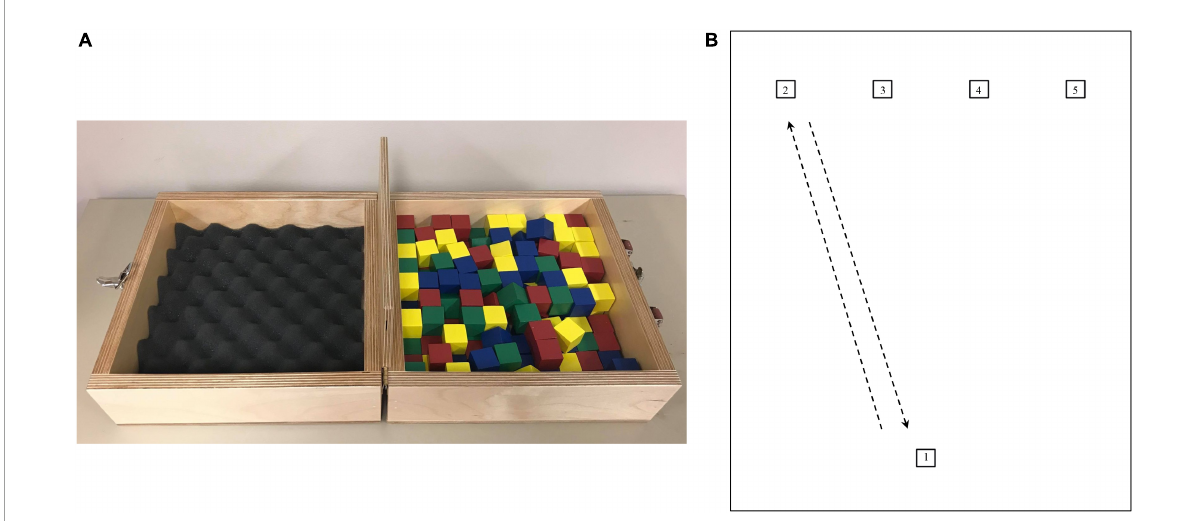
FIGURE1 (A) Illustration of the box and block test (Mathiowetz et al., 1985) used in experiments 1 and 2. Briefly, participants had to grasp one block at a time with the dominant hand, transport the block over the partition, and release it into the opposite compartment. (B) Illustration of the pointing task used in experiment 1. Starting from target 1, participants had to go back and forth between each target. Right-handed participants started by reaching target 2 for their first-round trip, while left-handed participants started by reaching target 5 for their first-round trip. Measures are being taken from the center of all squares (1 × 1 cm). The distance between each upper square is 5.1 cm. The distance between targets 1–2 and 1–5 is 22.3 cm, respectively. The distance between targets 1–3 and 1–4 is 21 cm,